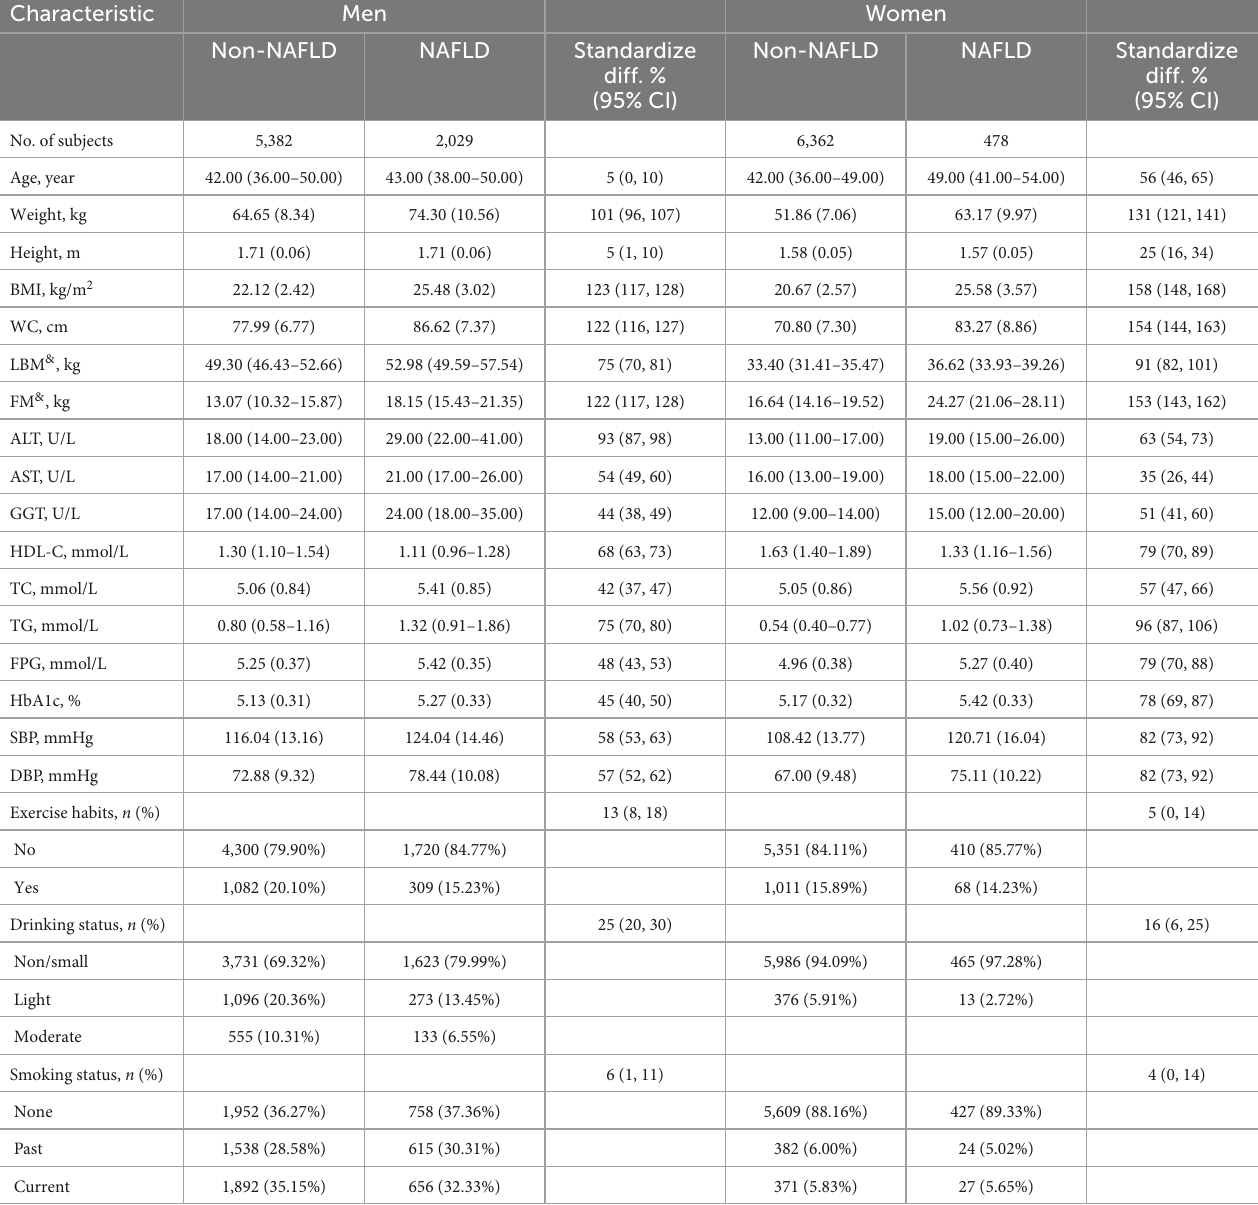
TABLE 2 Baseline characteristics of subjects grouped by sex and non-alcoholic fatty liver disease (NAFLD).